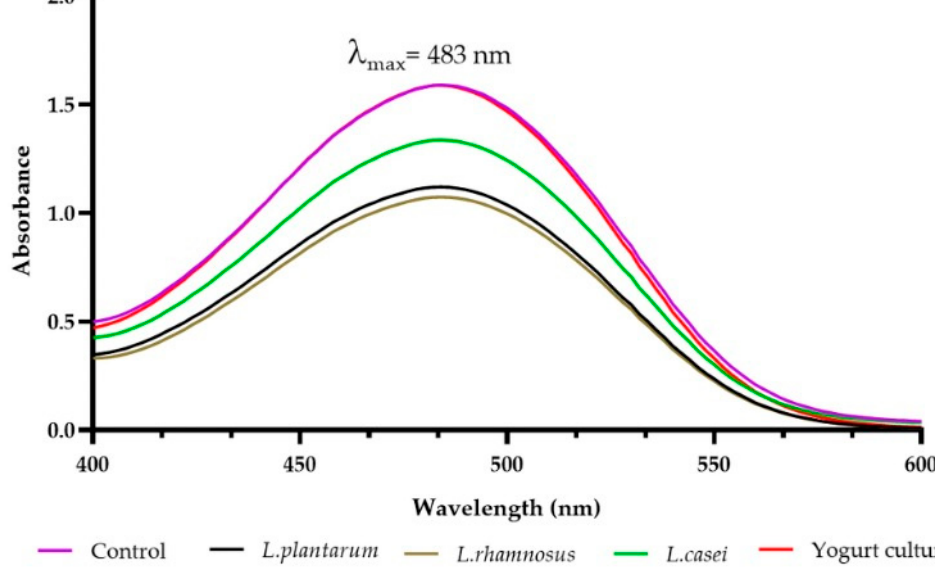
Figure 3. Changes in canthaxanthin absorbance